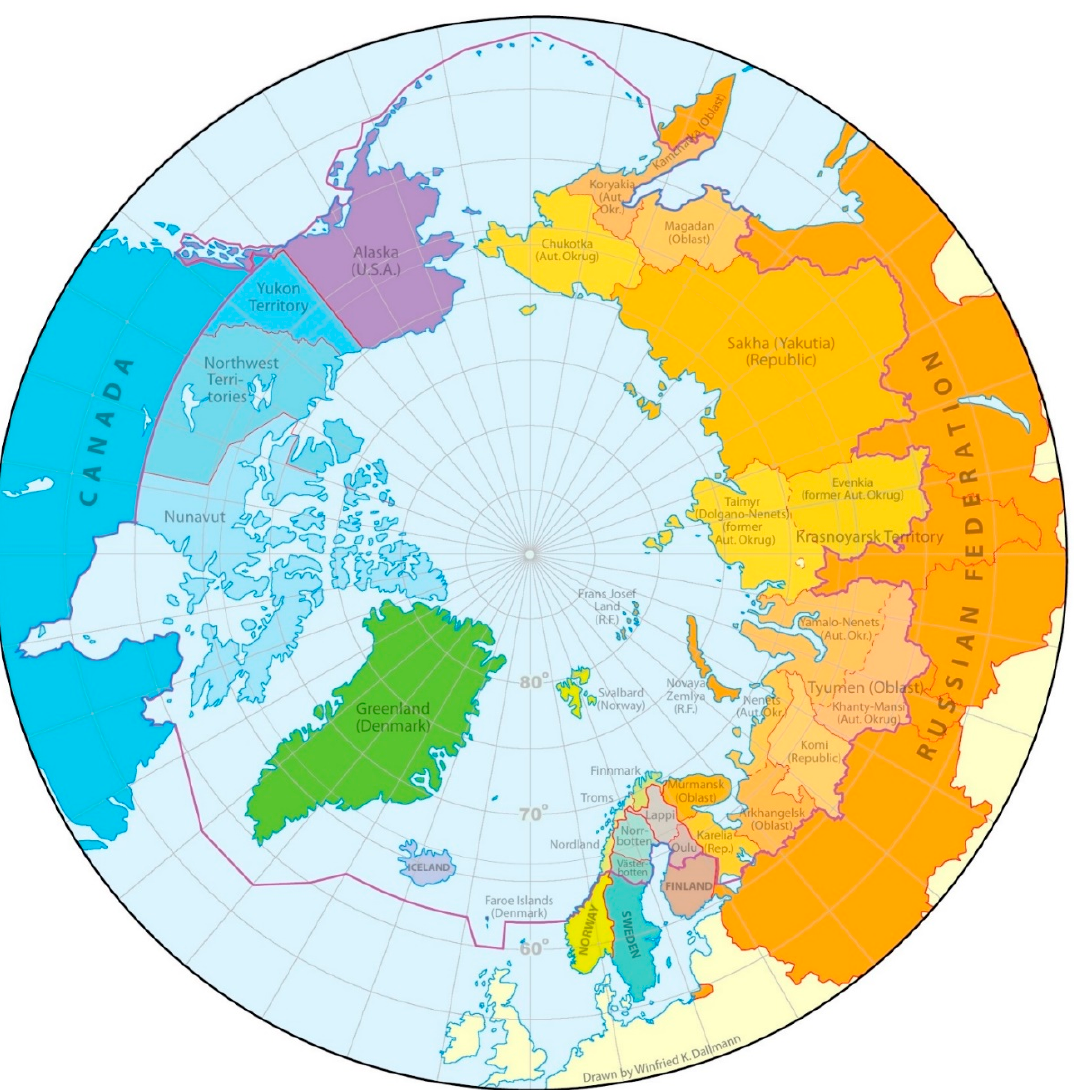
Figure 2. Arctic administrative areas. Map courtesy of Winfried K. Dallmann, Norwegian Polar Institute/Arctic Council.